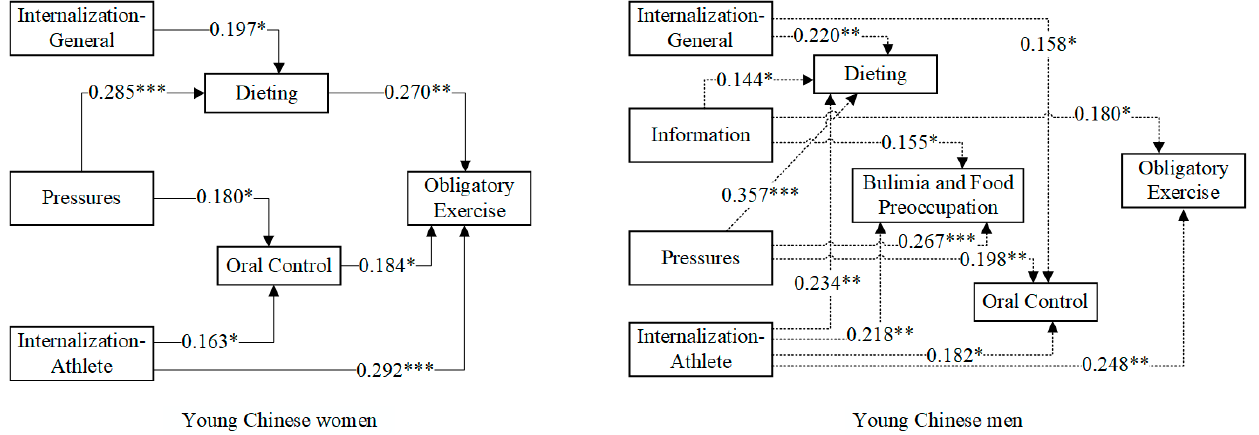
Figure 3. Sociocultural (Internalization—General, Information, Pressures, and Internalization—Athlete) and eating attitudes (Dieting, Bulimia and Food Preoccupation, and Oral Control) predictors of obligatory exercise among young Chinese men and women (n = 355). Note: Non-standardized estimates are presented—* p < 0.05, ** p < 0.01, *** p < 0.001—to improve the readability of the presentation; only paths with significance levels <0.05 were retained. Table 3. Model estimates for direct prediction of four variables on sociocultural attitudes toward the body and indirect prediction of obligatory exercise through three variables on eating